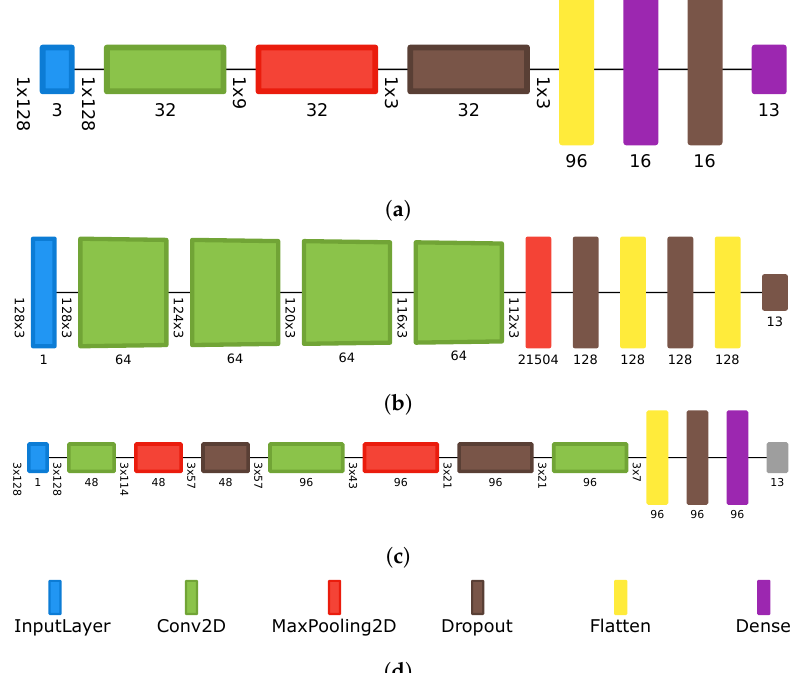
Figure 1. Visualizations of the different architectures evaluated. ( a ) The architecture of the custom CNN. ( b ) The architecture of the deep CNN. ( c ) The architecture of PerceptionNet. ( d ) Architecture